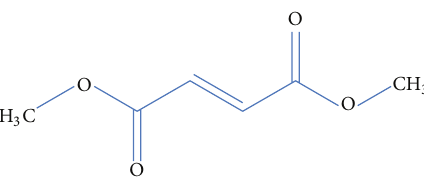
Figure 2: Chemical structure of